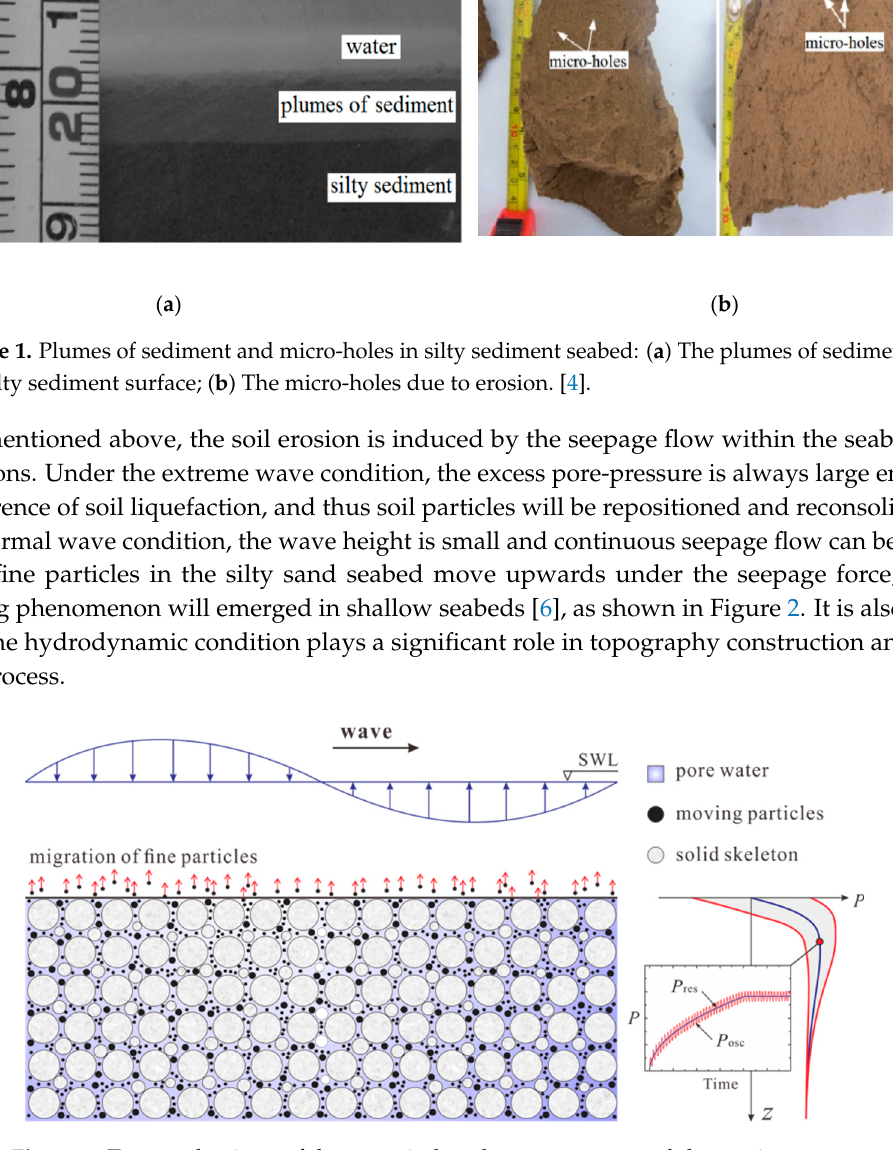
Figure 2. Two mechanisms of the wave-induced pore-pressure and the erosion process.